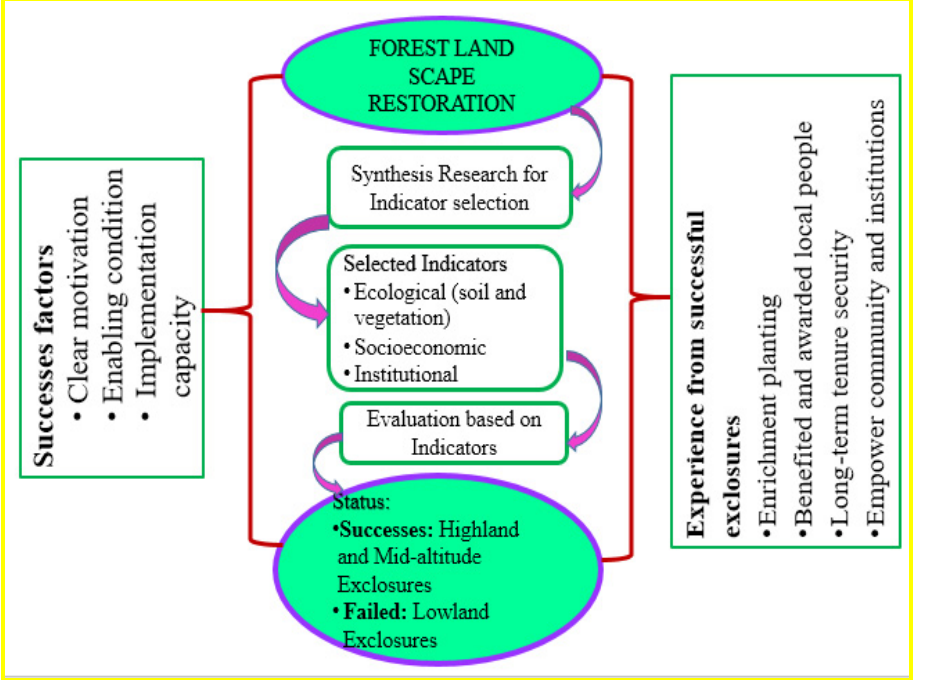
Figure 8. Conceptual framework for Forest Landscape Restoration.